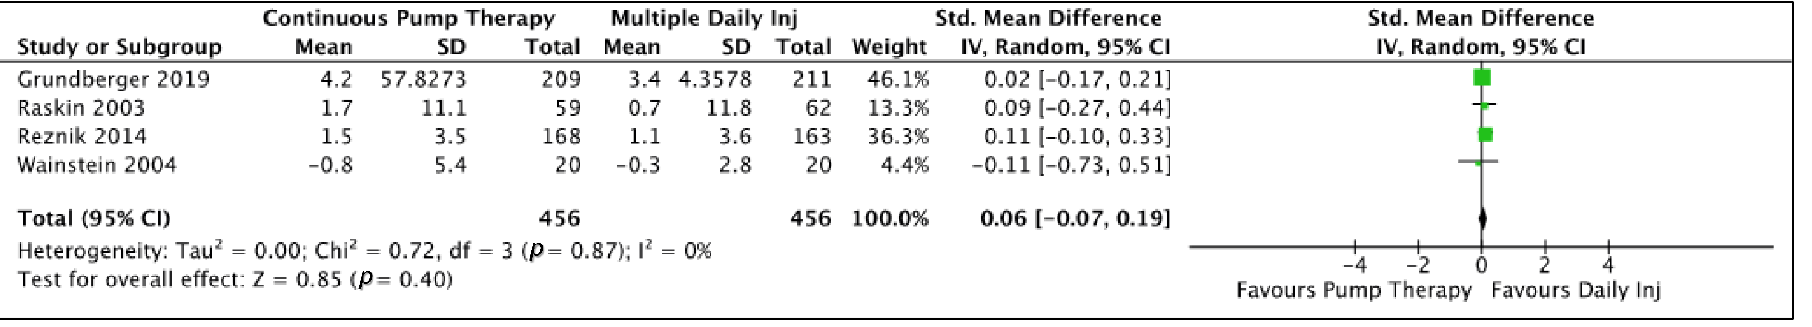
Figure 6. Meta-analysis results and Forest plot for body weight.